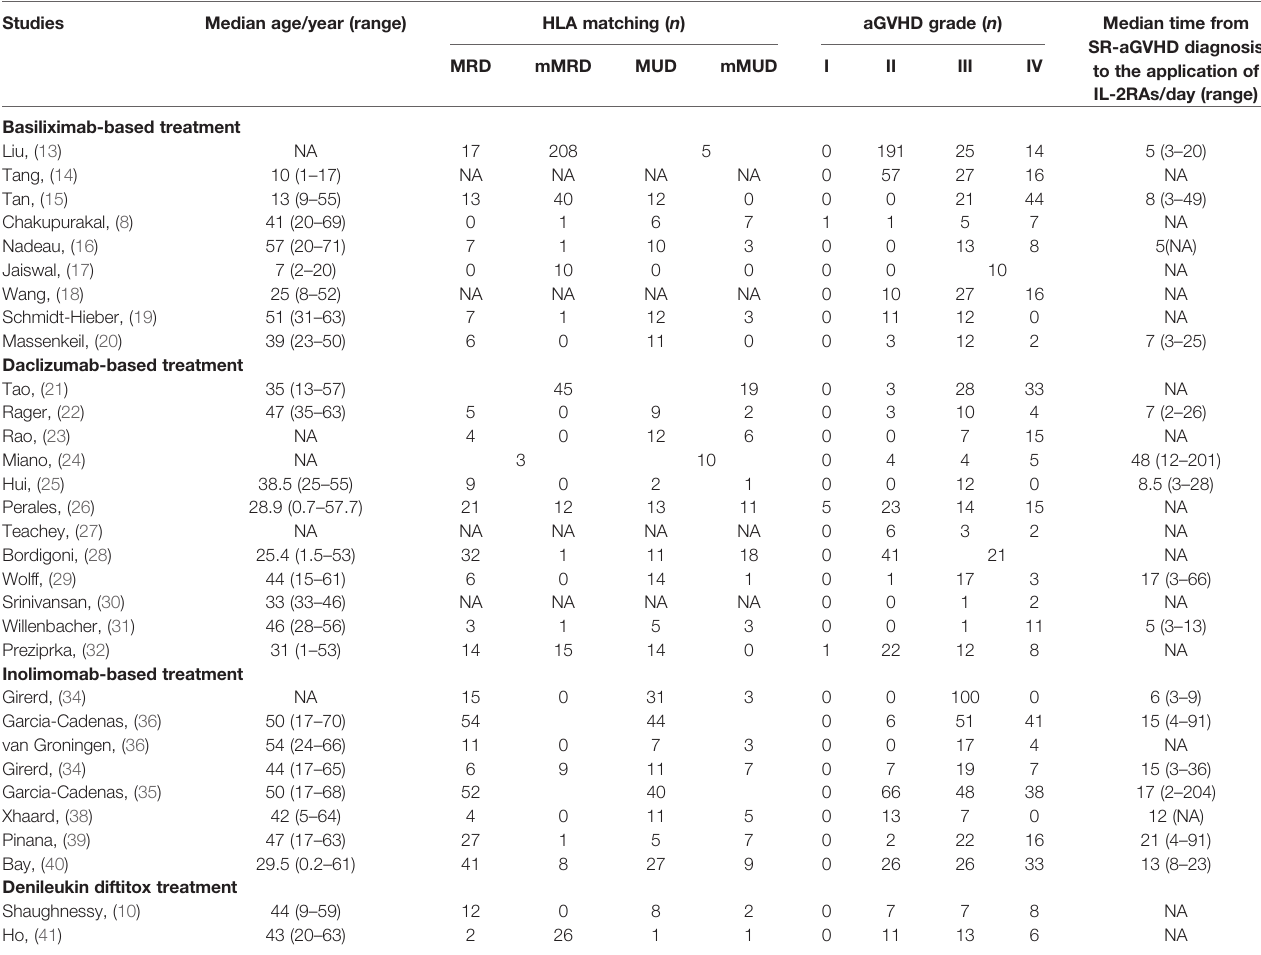
TABLE 2 | Other characteristics of 31 included